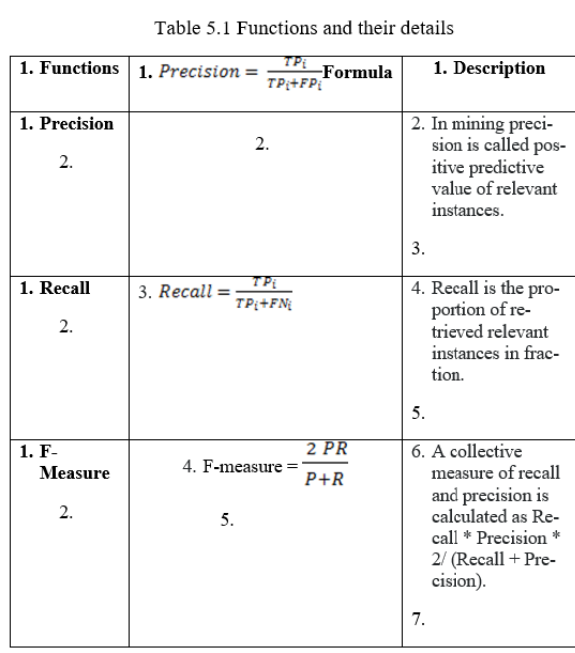
Table5.1 meaning in the context of our study: